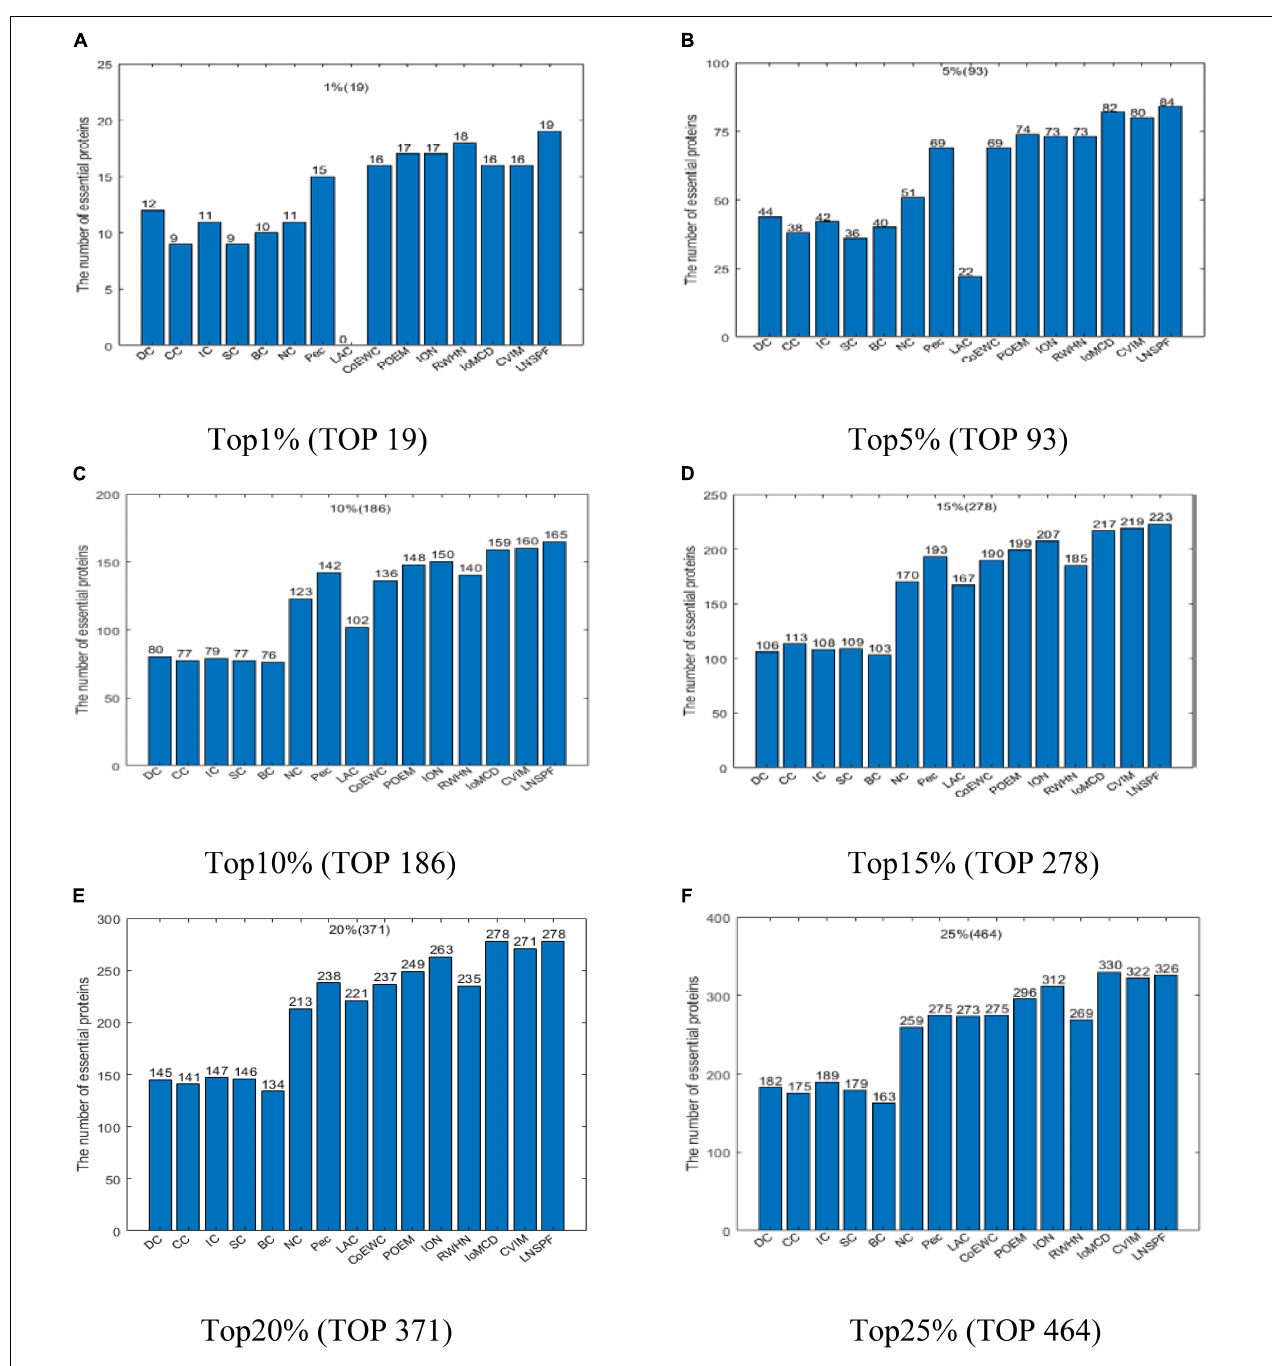
FIGURE 2 | Comparison results of the numbers of real key proteins predicted by LNSPF, DC, CC, IC, SC, BC, NC, PEC, LAC, CoEWC, POEM, ION, RWHN, IoMCD, and CVIM based on the GAVIN database. (A) Top 1% ranked proteins. (B) Top 5% ranked proteins. (C) Top 10% ranked proteins. (D) Top 15% ranked proteins. (E) Top 20% ranked proteins. (F) Top 25% ranked